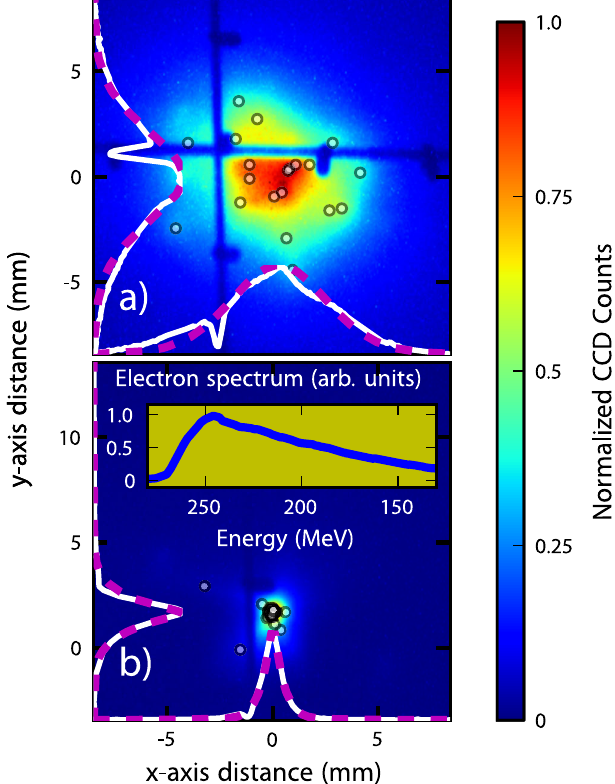
FIG. 2. Electron beam spatial stability improvement: False color images observed at S1, 1.12 m behind the source (experi- mental subfigures are each normalized to one). (a) Sum of 20 consecutive electron beams and peak positions of each shot (dots). Shot-to-shot pointing fluctuations as well as the beam divergence lead to FWHM widths in the summed signal of 5 : 3 (cid:4) 5 : 2 mm ( x axis (cid:4) y axis). (b) Sum of 47 consecutive electron beams with a magnetic lens doublet set to collimate 220 MeV electrons, the FWHM widths are reduced to 0 : 9 (cid:4) 1 : 2 mm ( x axis (cid:4) y axis). The inset shows a sum of 30 electron beam spectra taken shortly before. Despite the chroma- ticity of the magnetic lenses, the beam collimation is still effective even with an FWHM energy spread of 80 MeV ( (cid:1) 35% ). Results from particle tracking are shown as lineouts (magenta dashed lines) which have already been convoluted with the instrument function of the detection system of S1 in order to compare directly with the experimental lineouts (white solid